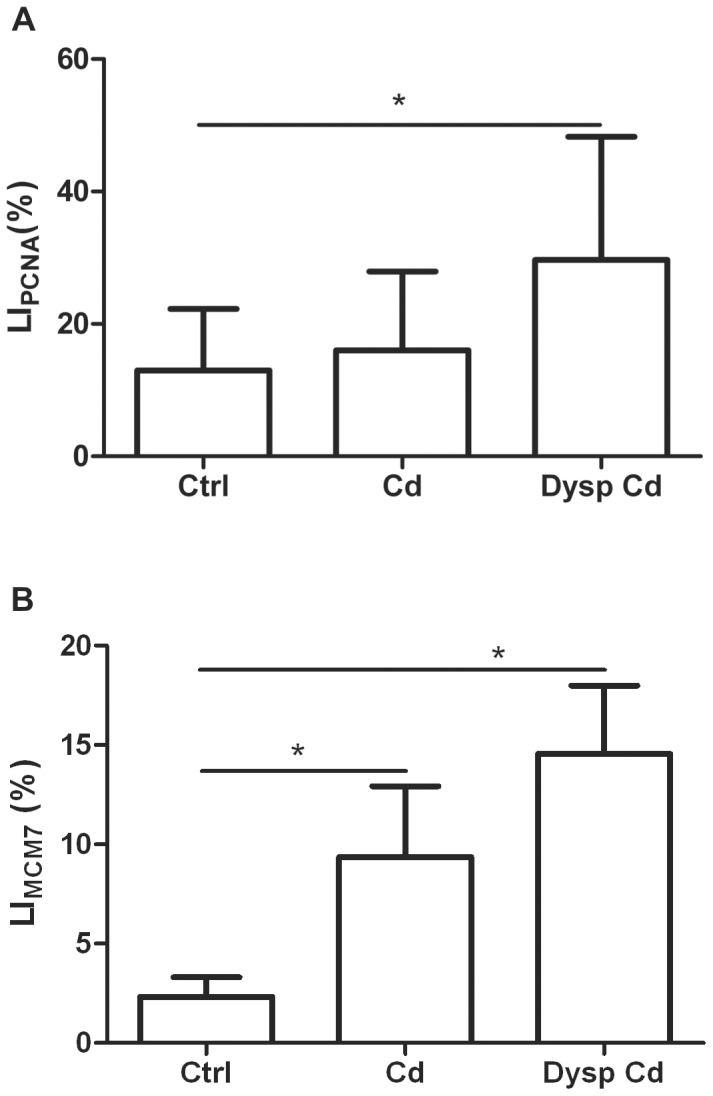
Bar graphs of the values of LIPCNA (A) and LIMCM7.Results are expressed as mean ± SD. Lines and asterisks indicate statistically significant differences (*p<0.05).